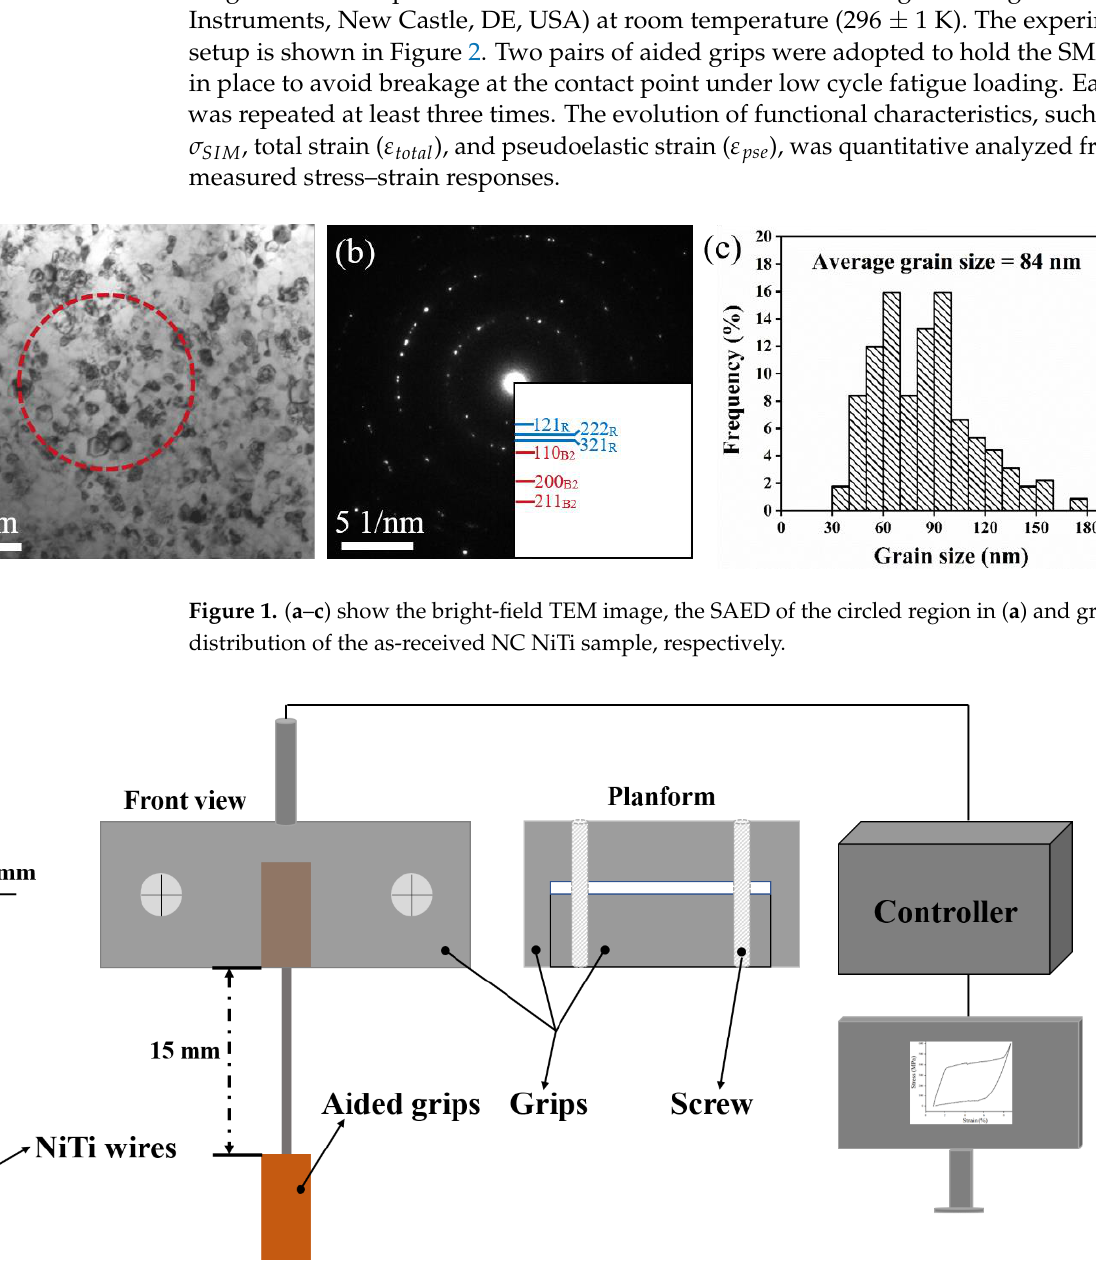
Figure 2. The geometrical representations of the real samples and the fatigue analysis apparatus.